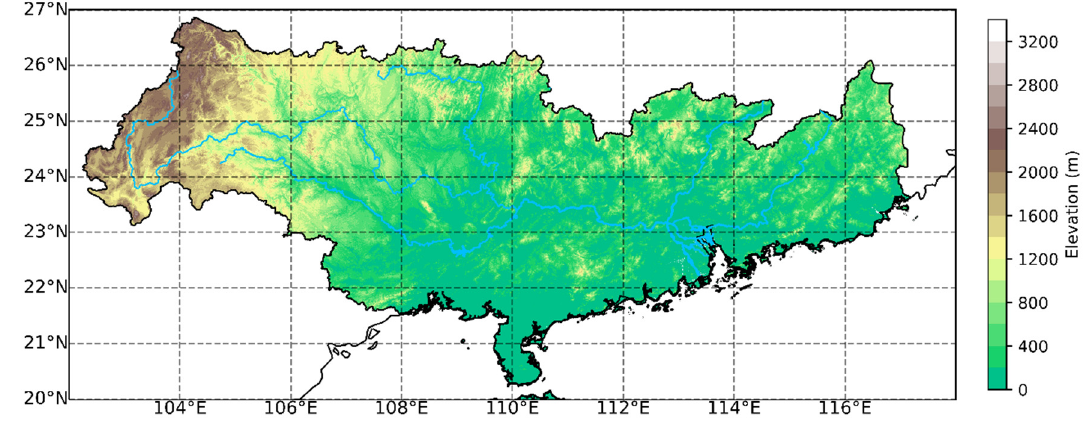
Figure 1. Altitude of the study area.